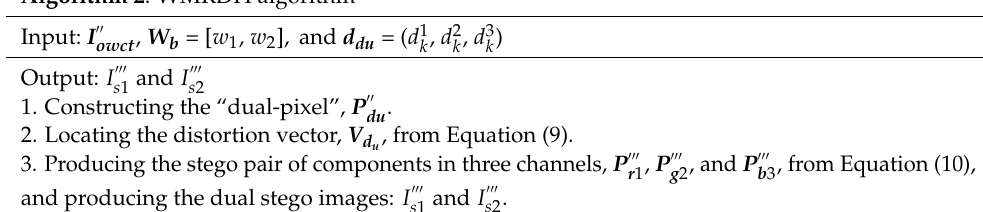
Algorithm 2 . WMRDH